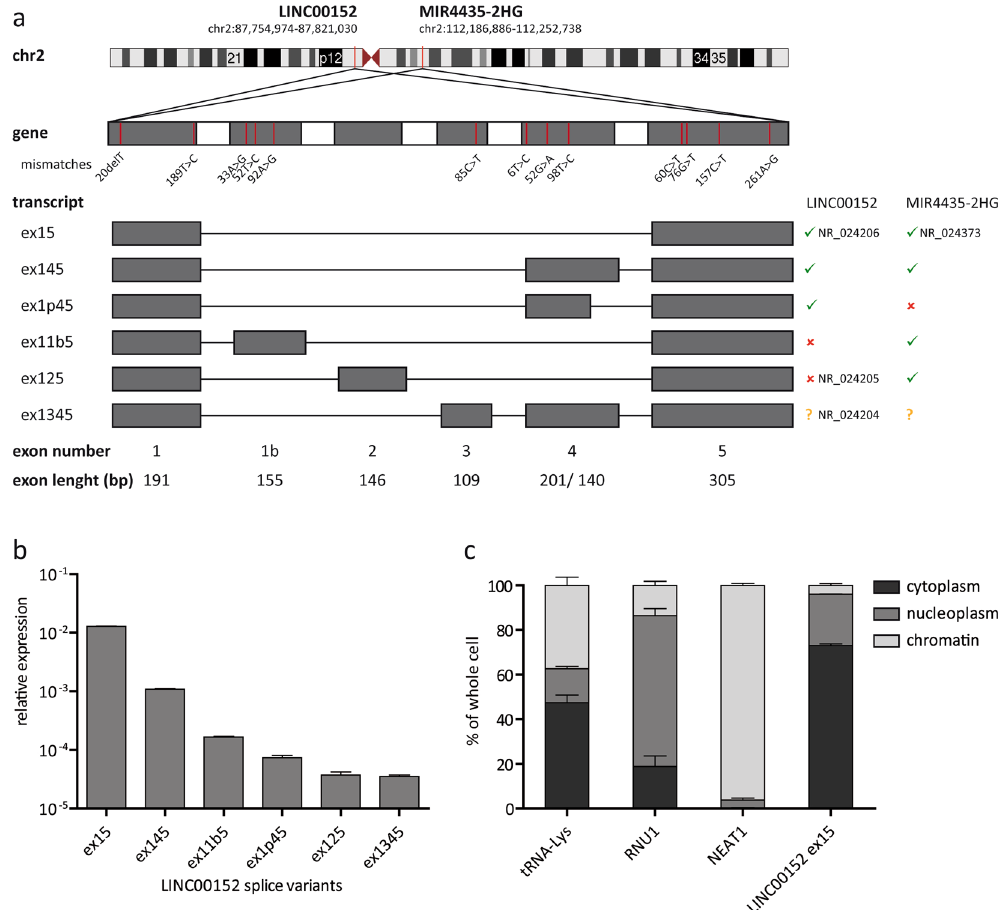
Figure 2. LINC00152 transcripts and their subcellular localization. ( a ) The exonic regions of LINC00152 and MIR4435-2HG differed only by 13 base pairs (upper panel, mismatch numbers were counted for each exon separately). Exons were numbered according to their genomic order and transcripts were named according to their comprised exons. Both paralogs were transcribed into several isoforms (lower panel) and had splice variants ex15 and ex145 in common (right panel). ( b ) Relative expression of all identified LINC00152 splice variants determined by RT-qPCR normalized to Cyclophilin A expression. Note that the graph is depicted in Log10 scale. ( c ) Subcellular localization of LINC00152 was determined using cell fractionation. After separation of cytoplasm, nucleoplasm and chromatin, RNA was extracted from all fractions and LINC00152 expression was measured by RT-qPCR. tRNA-Lys, RNU1 and NEAT1 were used as cytoplasmic, nucleoplasmic and chromatin marker, respectively. N = 3. Error bars indicate